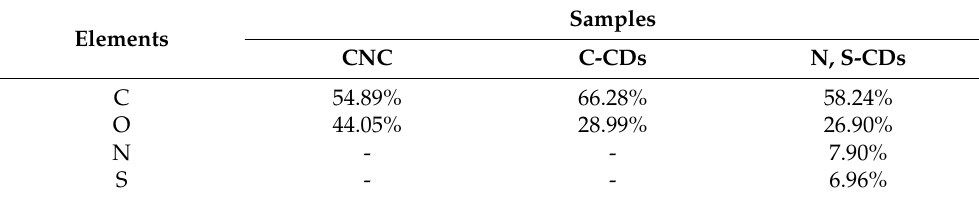
Table 1. The contents of C, O, N, and S elements in N, S-CDs according to XPS analysis. Samples Elements CNC C-CDs N,